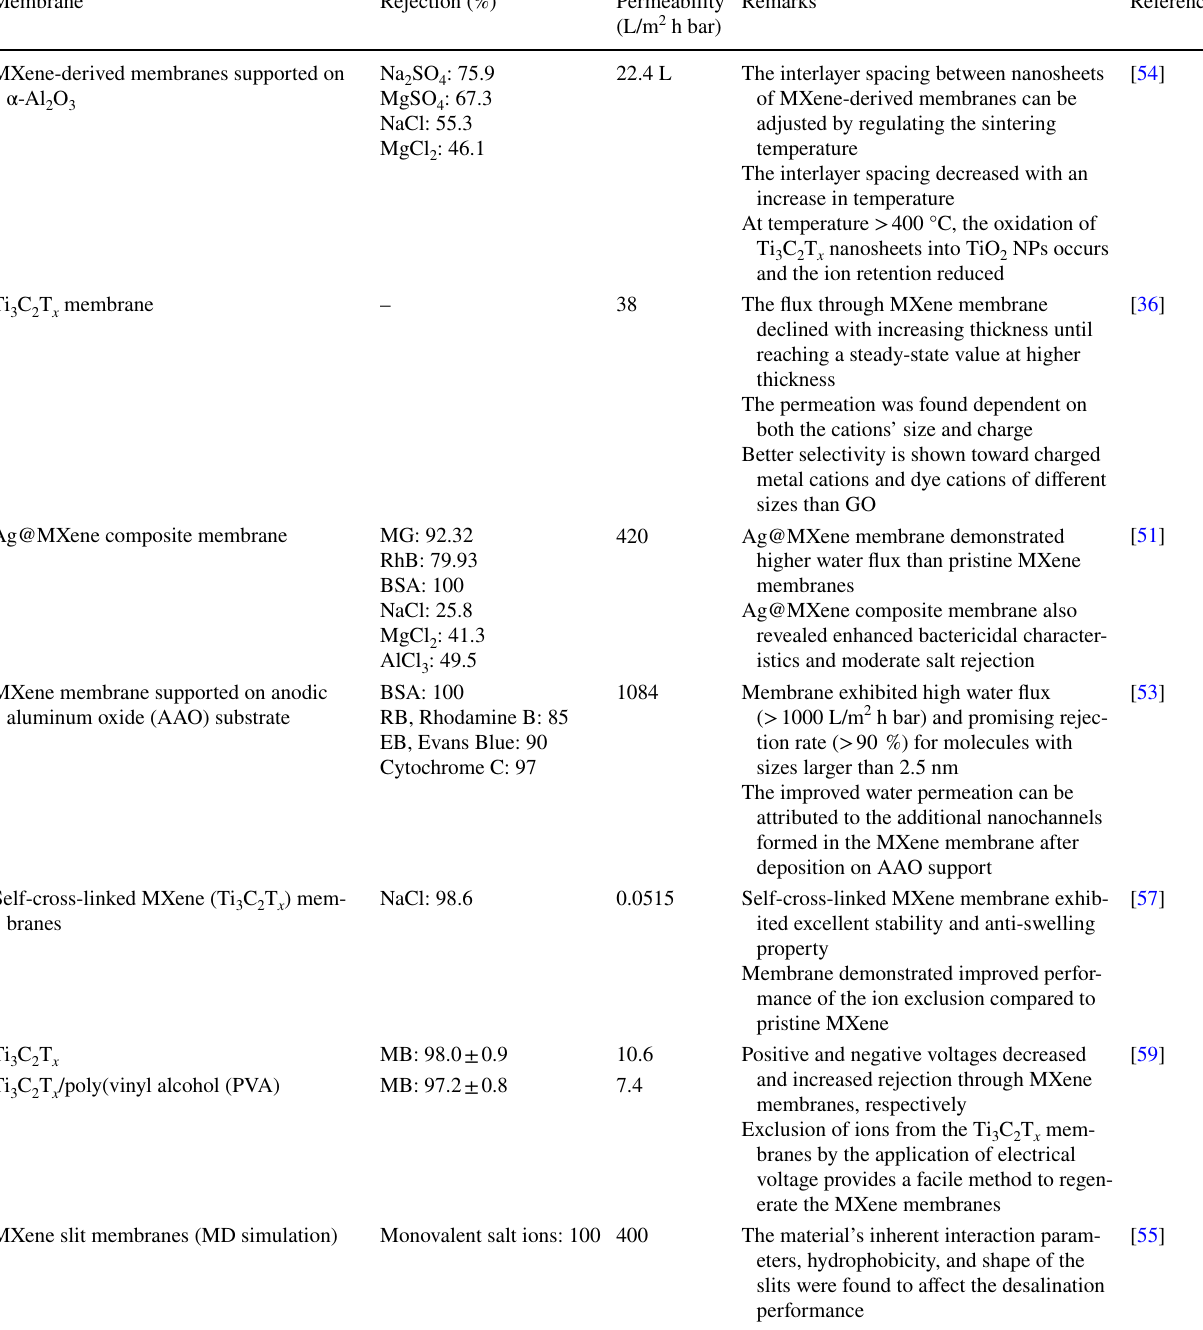
Table 1 Ion sieving performance evaluation of different MXene membranes Membrane Rejection